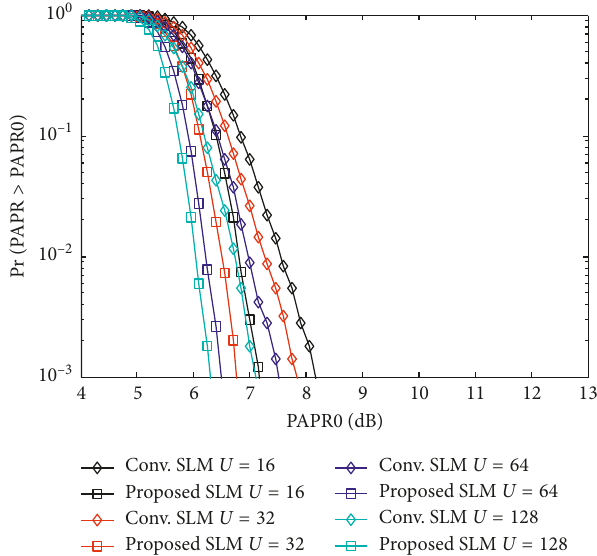
Figure 16: Comparison of SLM given in [5] with the proposed SLM for U � 16, 32, 64, and 128, N � 128, and 16-PSK.